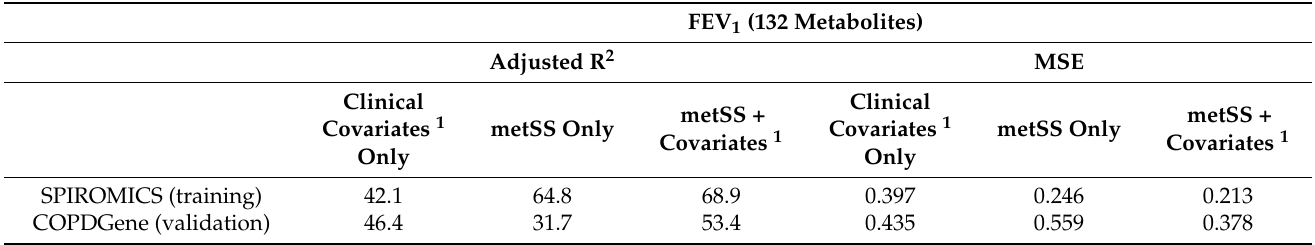
Table 3. Adjusted R 2 and Mean Squared Error (MSE) to assess Linear Regression Models for post- bronchodilator FEV 1 (L).